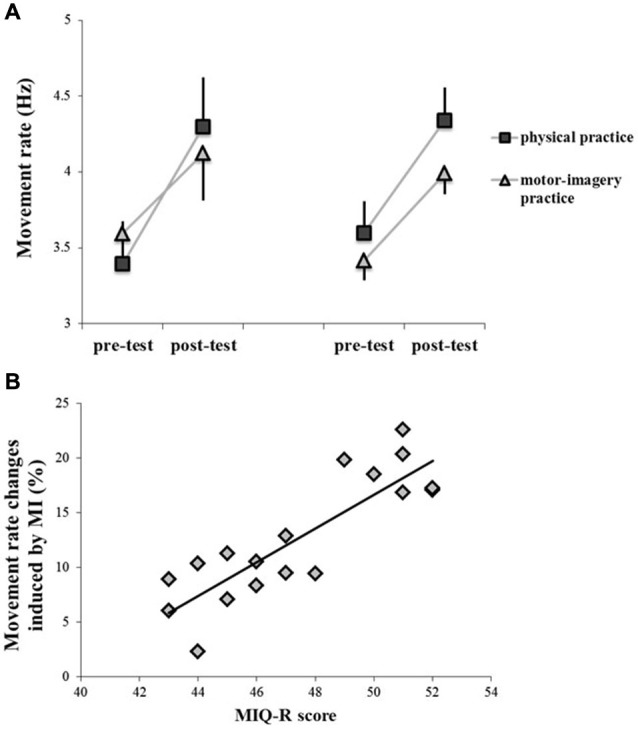
Behavioral data, showing the rate of execution of sequential finger tapping movements before (pre-test) and after (post-test) the different types of training (physical practice and motor-imagery practice) (panel A). Data of both GROUPPAS10 (left side) and GROUPPAS25 (right side) are shown. Vertical bars indicate SE. Panel (B) shows the correlation between individual changes in movement rate induced by motor-imagery (MI) practice and individual scores at the MIQ-R questionnaire. Changes in movement rate (Y-axis) were evaluated as follows:(post-test − pre-test)/post-test × 100) (r = 0.85; p < 0.001).